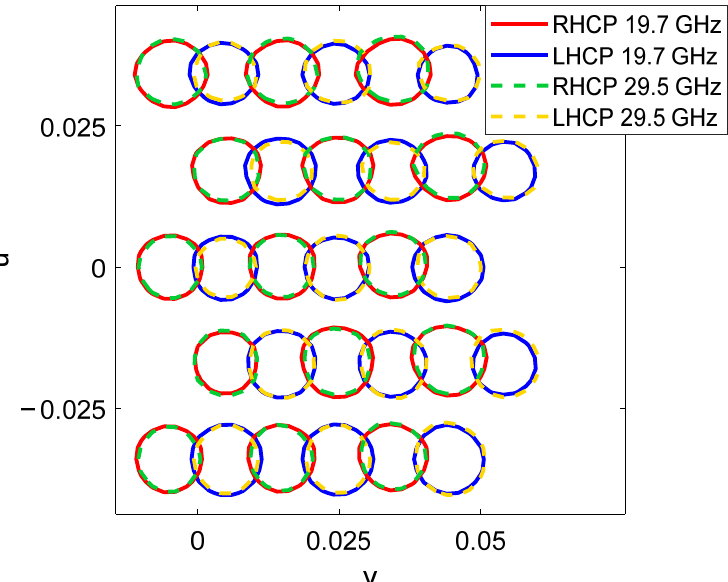
Figure 13. Simulated pattern contours for the 30 beams generated by 15 feeds illuminating the proposed dual reflectarray at 19.7 GHz and 29.5 GHz.